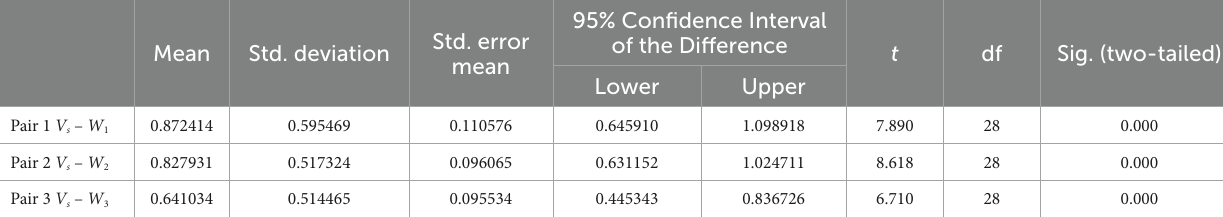
TABLE 5 Paired t -test of the subjects’ speech rate and the expected feedback speech rate.